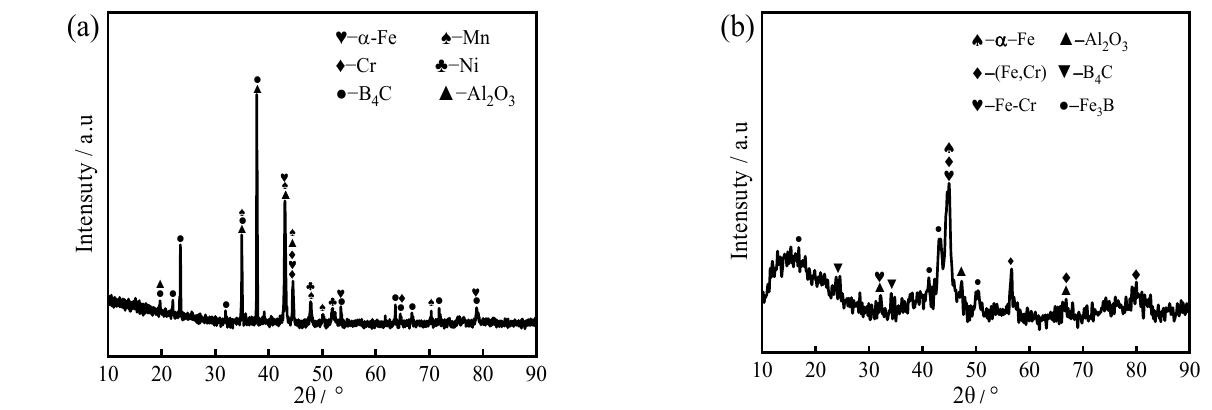
Figure 2. XRD pattern ( a ) powder; ( b ) Fe-based-Al 2 O 3 -B 4 C coating. Table 6 . Atomic radii of different elements .